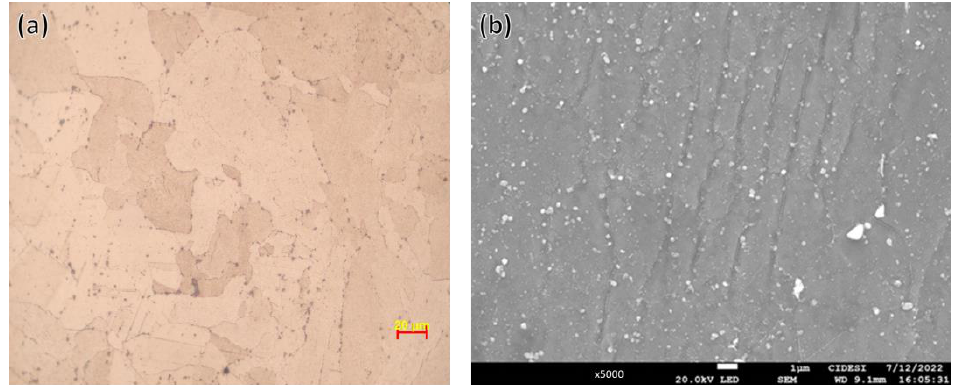
Figure 5. Microstructure at 500× of cellular IN718 after 8 h of aging. ( a ) Optical microscopy at 500×. ( b ) SEM image at 5000×